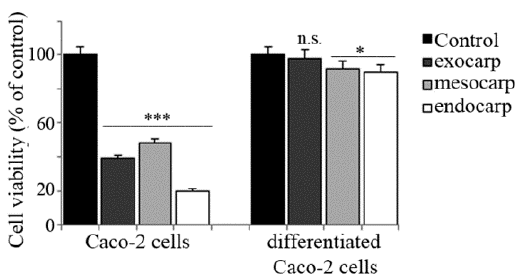
Figure 9. Comparative effects of litchi extracts on parental and differentiated Caco-2 cell viability. Caco-2 cells (3 × 10 5 cells/cm 2 ) were seeded on polyethylene terephthalate (PET) membrane inserts and allowed to differentiate for 21 days. Twenty-four hours before treatment, parental Caco-2 cells were also plated on PET membrane inserts. Then, the two cell lines were treated with 150 µg/mL of each litchi extract. The incubation was protracted for an additional 48 h and the cells were then subjected to an MTT assay as reported in the Materials and Methods. The results are representative of three independent experiments. (*) p < 0.05; (***) p < 0.001 compared with control.